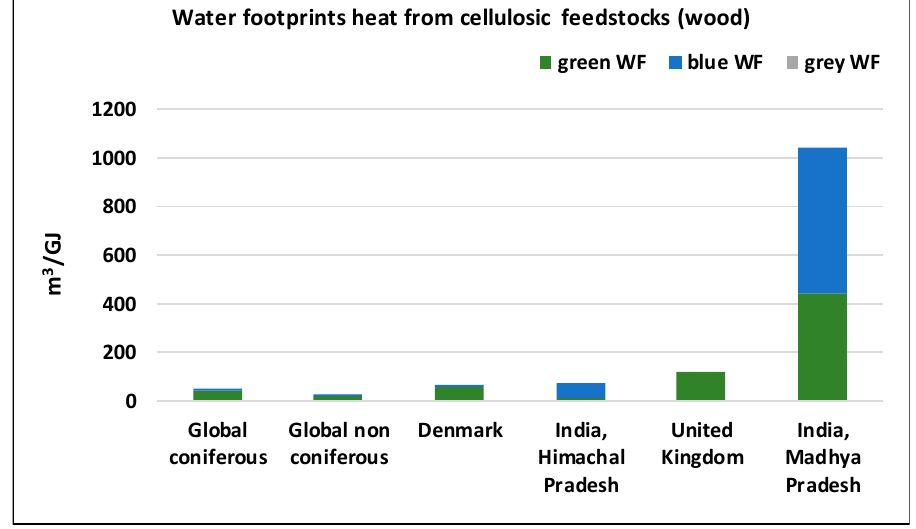
Figure 3. WFs of wood (source: Schyns et al. [14]; Das et al. [37]).